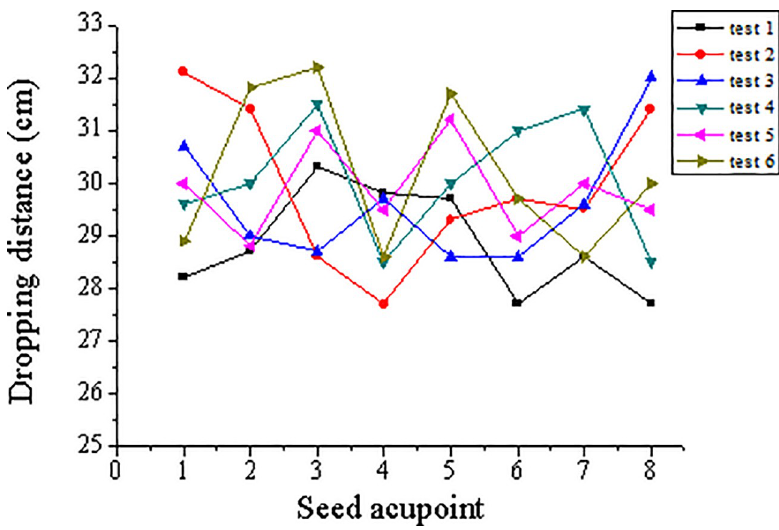
Fig 9. Precision positioning seeding experiment of corn under sine wave disturbance signal (1 Hz).